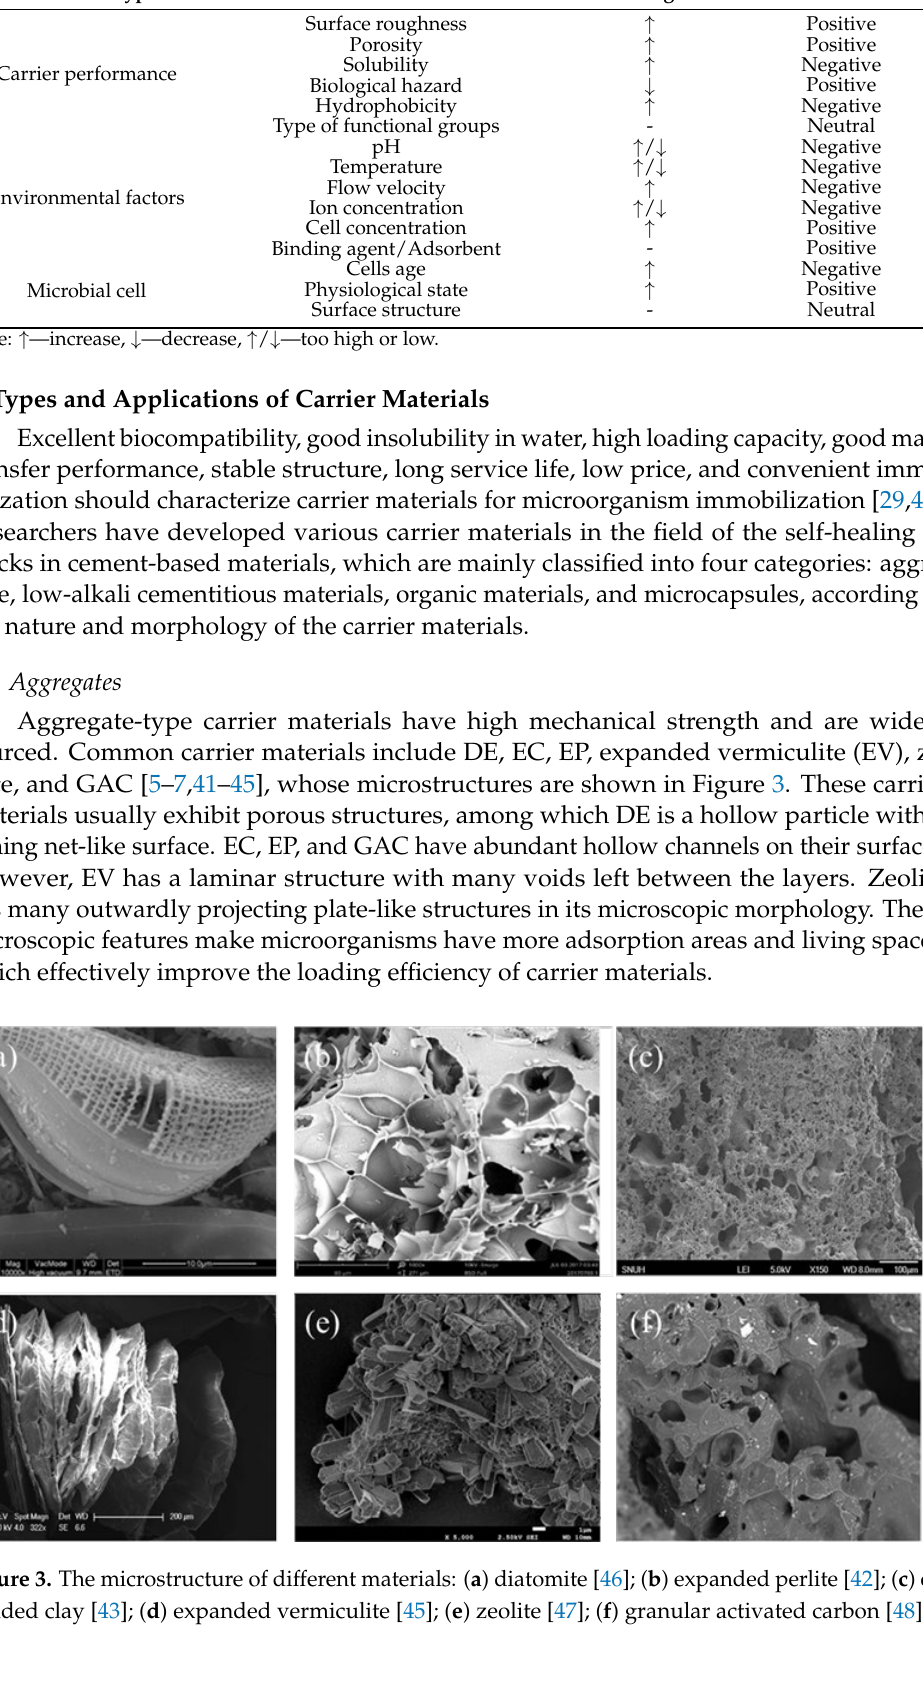
Table 1. Factors affecting the immobilization of microbial cells [27,37–39]. Parameter Type Parameter Change